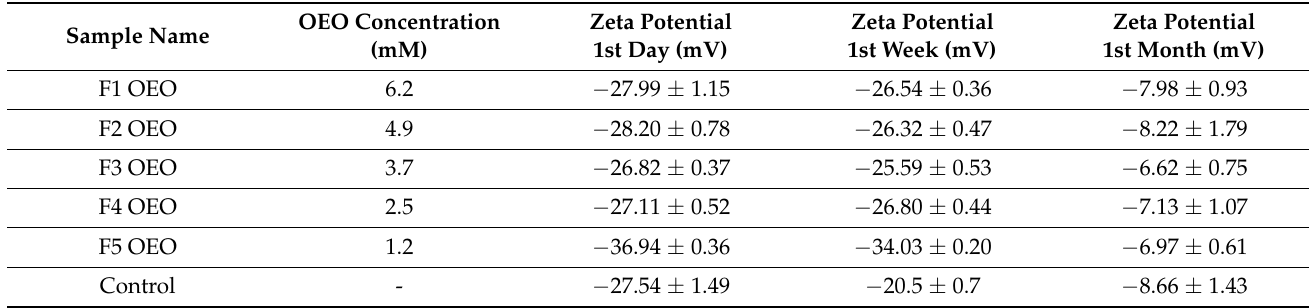
Table 2. Zeta potential values of OEO nanoliposomes and control samples at different concentrations after 1 day, 1 week, and 1 month of storage at 4 ◦ C.